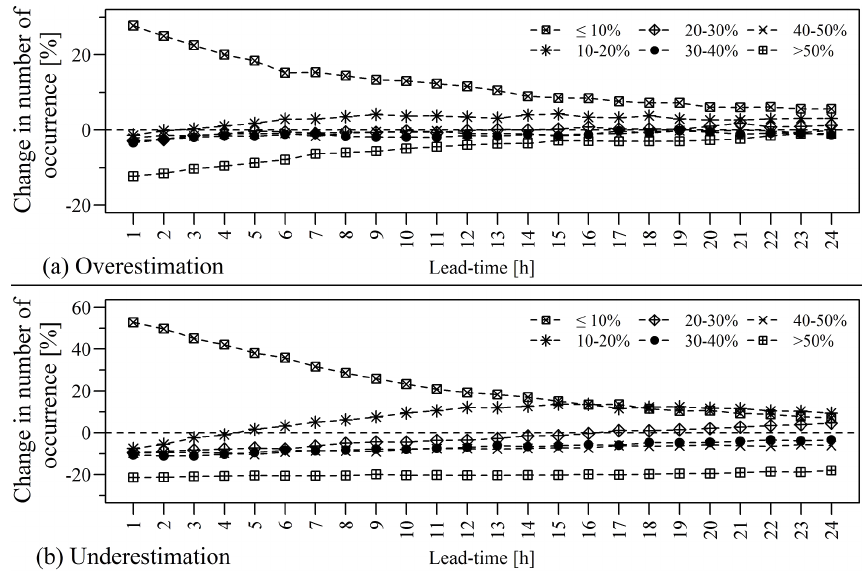
Figure 7. Change in number of occurrence of the six absolute PVE classes ( ≤ 10, 10–20, 20–30, 30–40, 40–50 and > 50%) as a function of forecast lead time: (a) overestimation and (b)